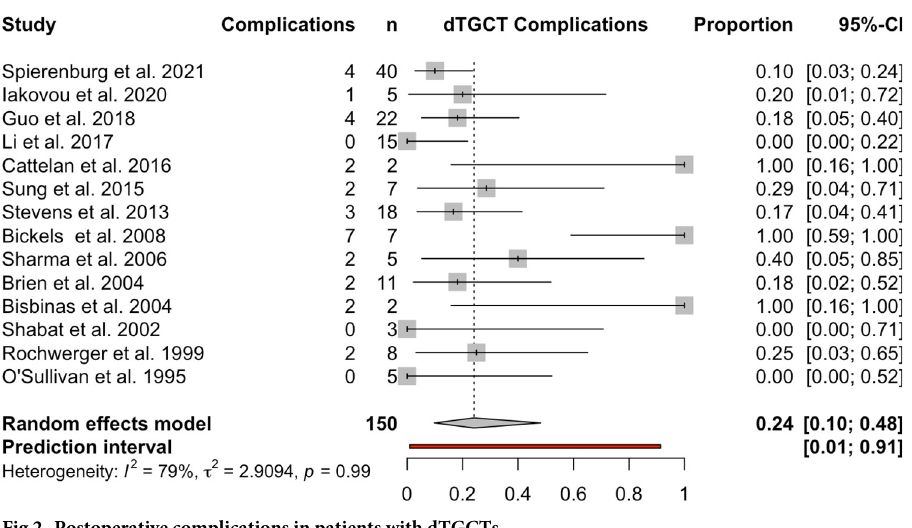
Fig 2. Postoperative complications in patients with